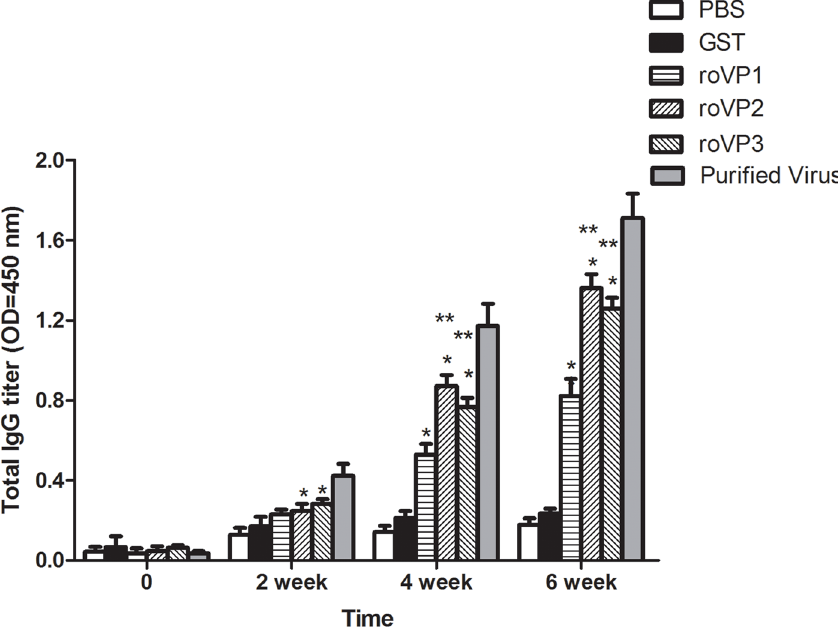
Fig 4. Specific IgG antibodies in serum of the immunized mice. * Significantly different than the GST- immunized group (p < 0.05). ** Significant differences between the three groups immunized with recombinant proteins (p < 0.05).